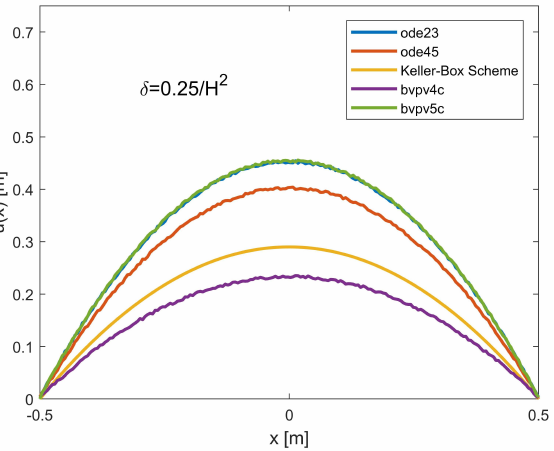
Figure 6. Profile recovery for δ = 0.25